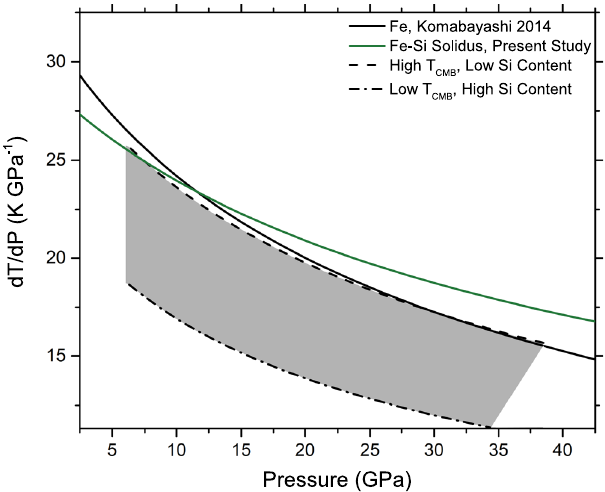
Fig. 4 Melting curve gradients (dT m /dP) and isentropic gradients (dT S / dP) vs. pressure for the Fe – Si system. Dashed lines and dash-dotted lines indicate the maximum range of dT S /dP compatible with compositional and thermodynamic constraints outlined in text. Solid lines show dT m /dP from the present study for the Fe – Si system, and from literature for Fe 59 . It is observed that the expected range of possible values for dT S /dP (shaded gray area) is systematically lower than dT m /dP for Fe (black) and in the Fe – Si system (green), indicating that an Fe – Si core would crystallize in a bottom-up